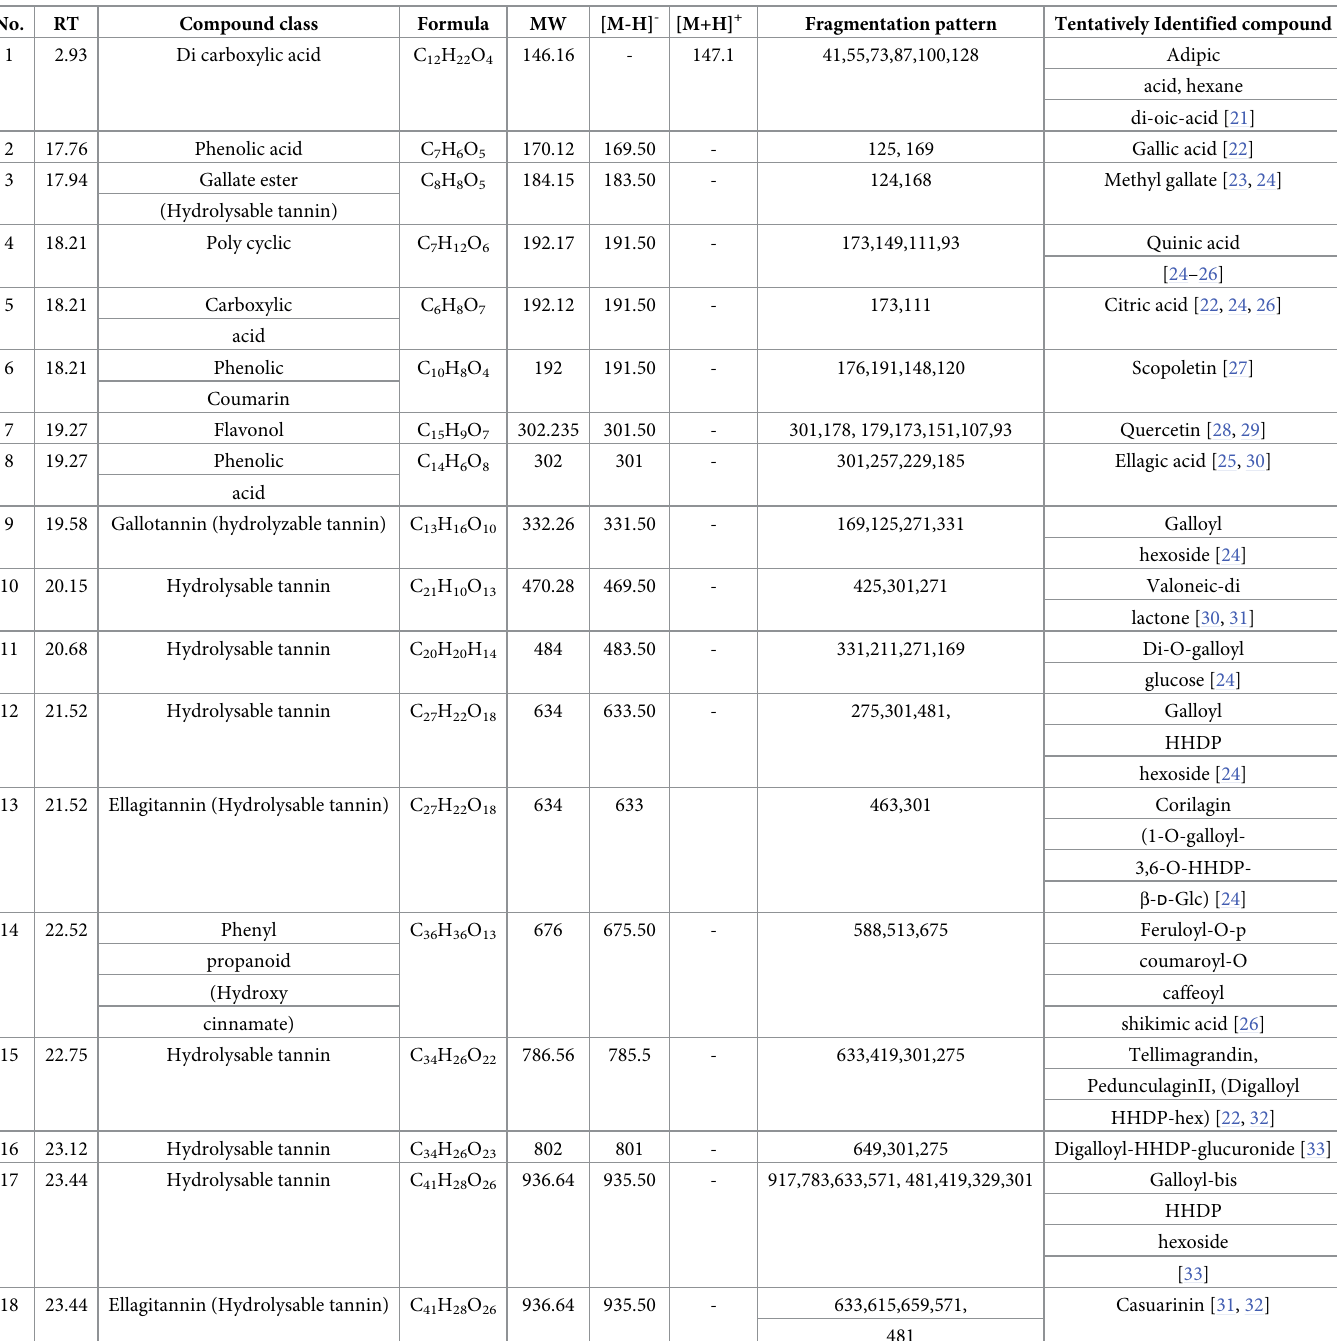
Table 4. The tentative identification of compounds by LCMS analysis of